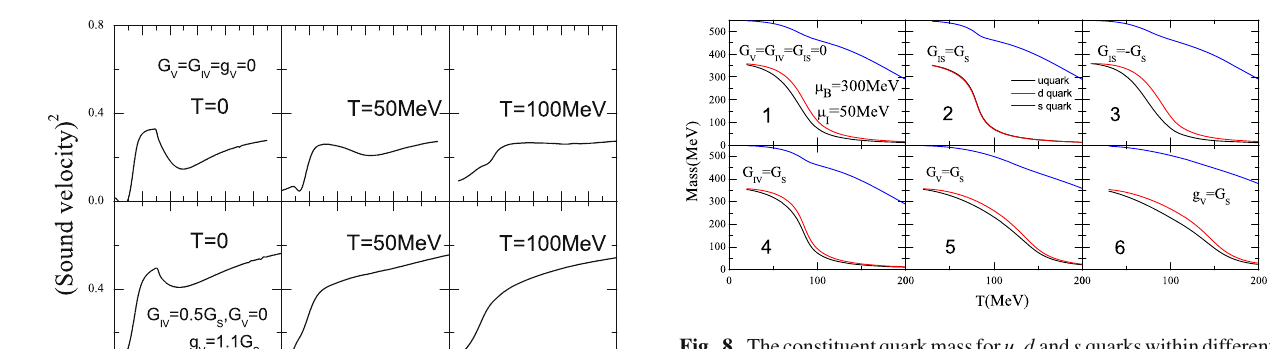
Fig. 8 Theconstituentquarkmassfor u , d and s quarkswithindifferent vector interactions